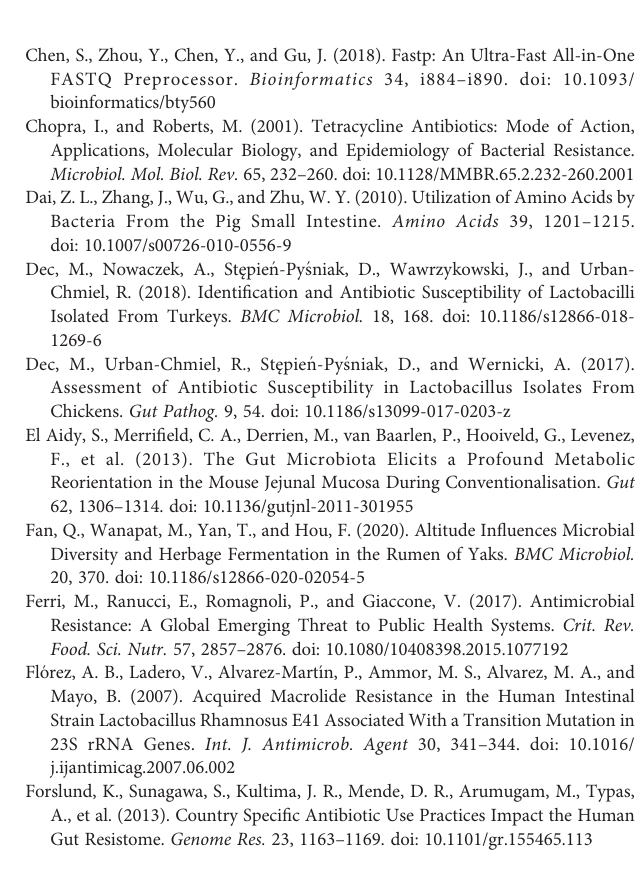
Supplementary Figure 1 | The LEfSe analysis was used to fi nd high-dimensional biomarkers in jejunum microorganisms of different pig breeds. Functional abundance through KEGG pathways. Supplementary Figure 2 | The LEfSe analysis was used to fi nd high-dimensional biomarkers in jejunum microorganisms of different pig breeds. Functional abundance through eggNOG. Supplementary Figure 3 | The LEfSe analysis was used to fi nd high-dimensional biomarkers in jejunum microorganisms of different pig breeds. Functional abundance through